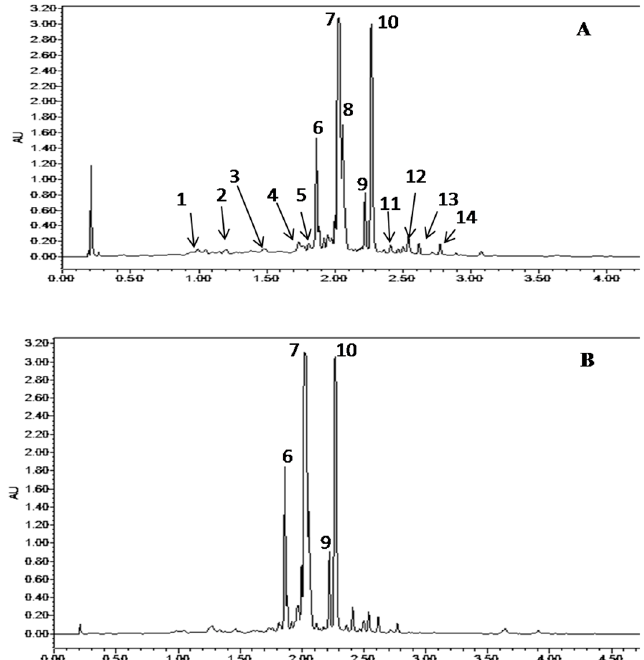
Figure 4. UV chromatograms of argan leaves analyzed by UPLC-ESI-HRMS ( A ) at 280 nm and ( B ) 320 nm. The different compounds were identified during the same run with the ESI-HRMS spec- tra. 1: Gallic acid; 2: (+)-Gallocatechin ; 3: ( − )-Epigallocatechin; 4: (+)-Catechin; 5: ( − )-Epicatechin; 6: